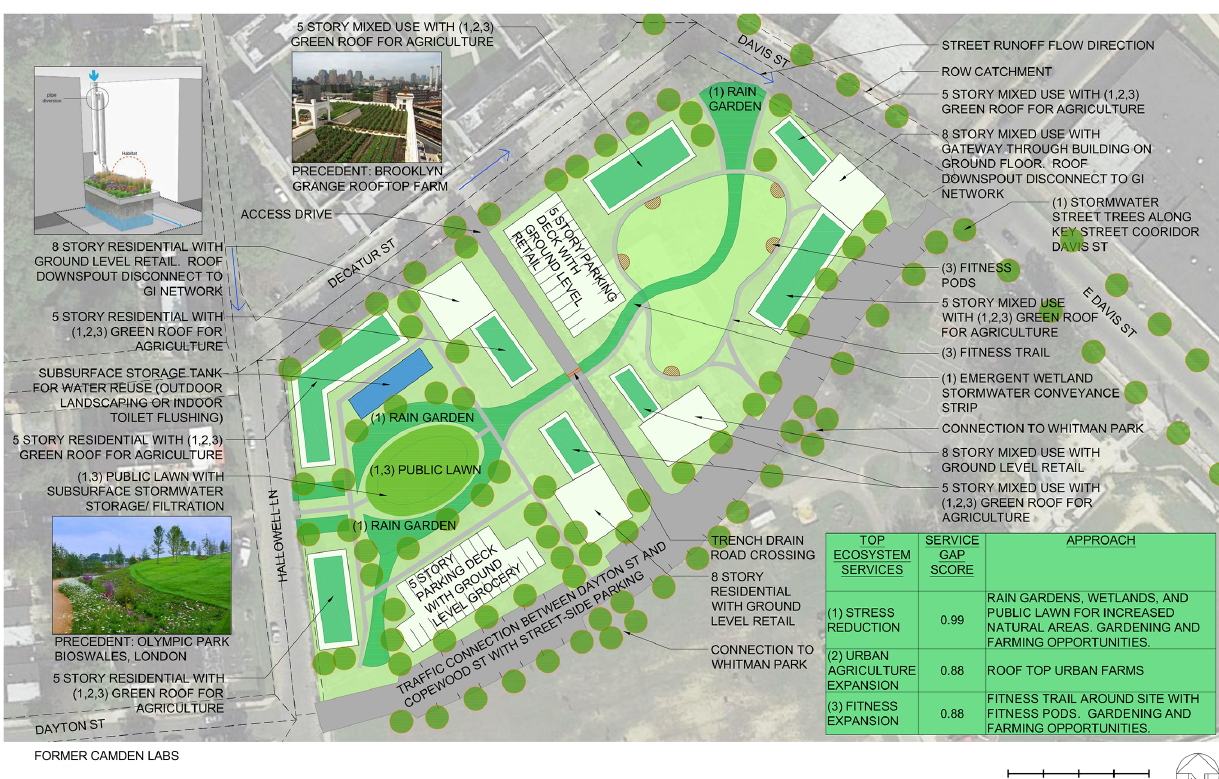
Figure 6. Former Camden Labs stormwater